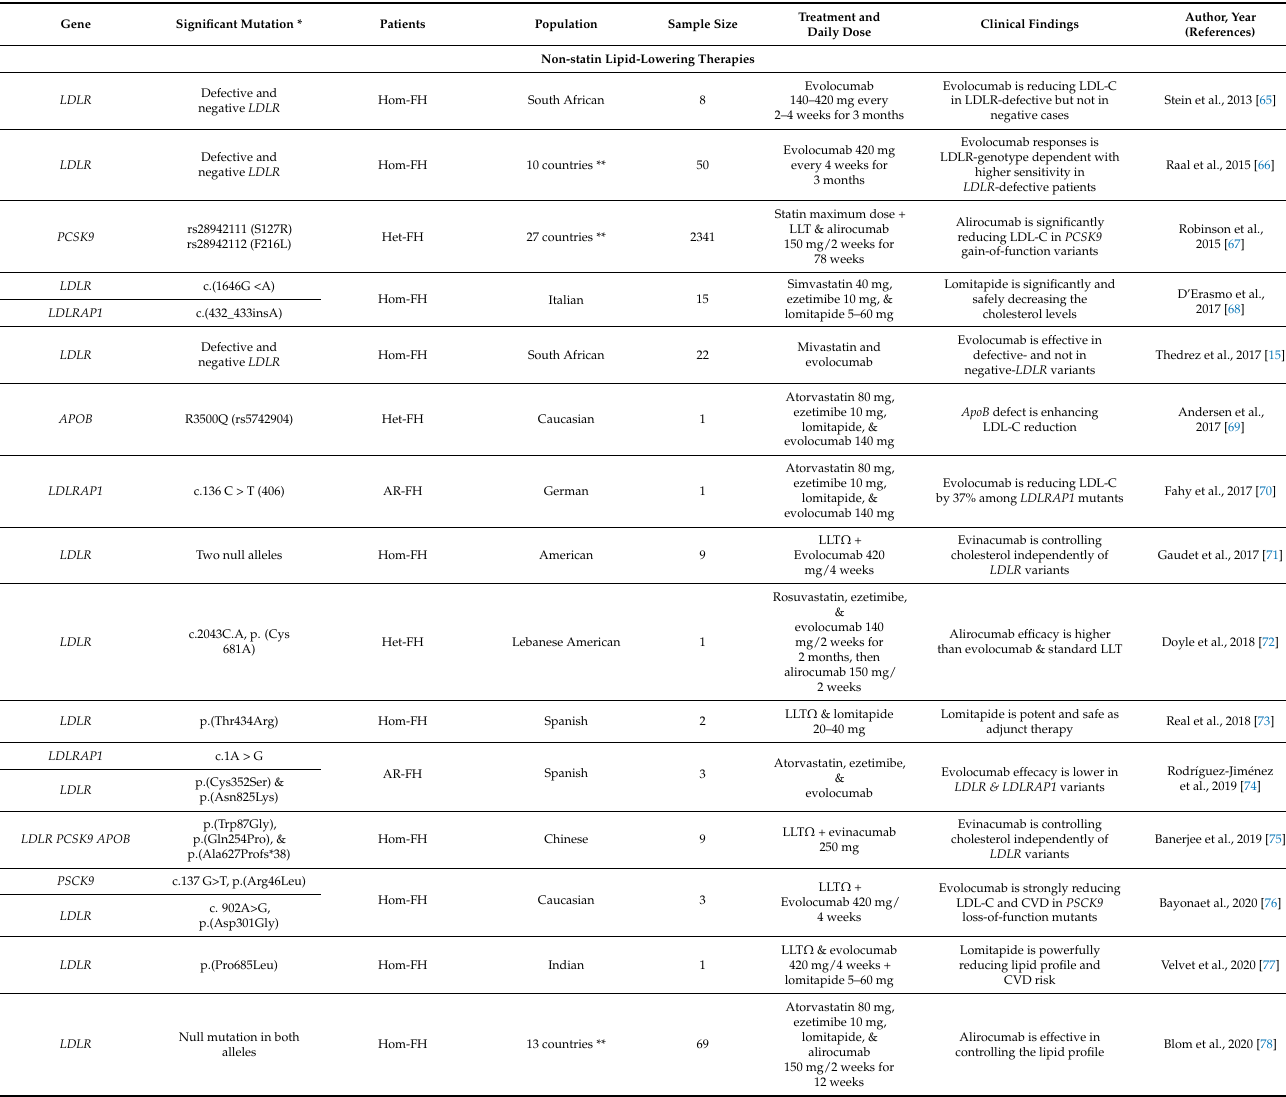
Table 2. Pharmacogenomics variations associated with non-statin & novel LLT responses in familial hypercholesterolemia